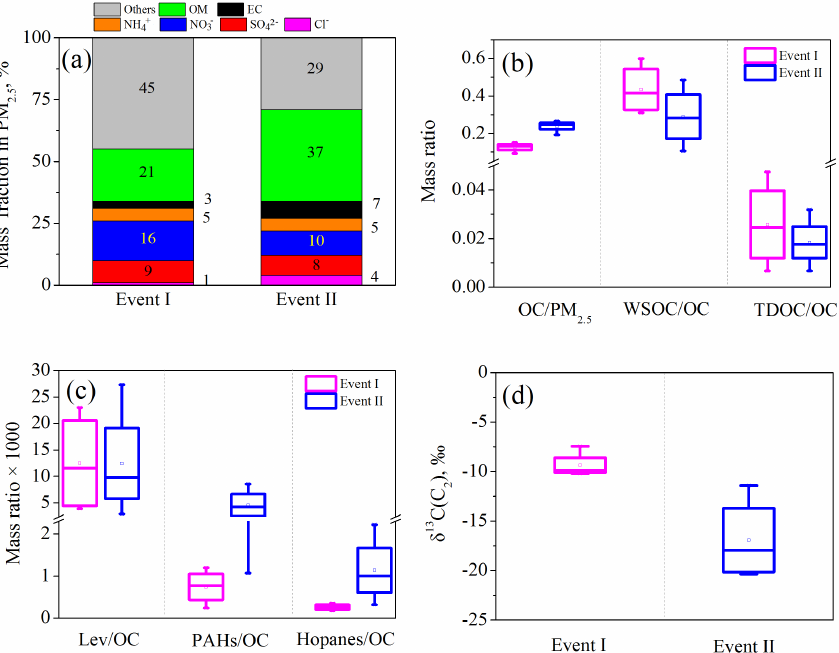
Figure 7. Comparison of chemical composition of PM 2 . 5 during two air pollution events. (a) Percentages of major species in PM 2 . 5 ; (b, c) mass ratios of major species and organic tracers in PM 2 . 5 ; (d) stable carbon isotope composition of oxalic acid (C 2 ) (data about levoglucosan (Lev), PAHs, and hopanes are cited from Wang et al.,